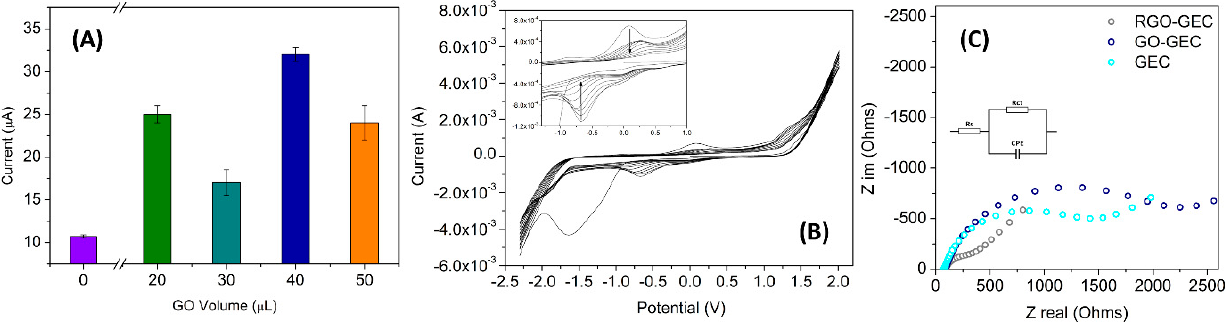
Figure 5. Optimization of the critical parameters for the use of the sensor. In ( A ) the deposited volume of GO via drop casting ( n = 3) ( B , C ) activation step of GO to RGO. ( B ) depiction of the 10 cycles reduction step; ( C ) shows the Nyquist plot after the reduction of GO.